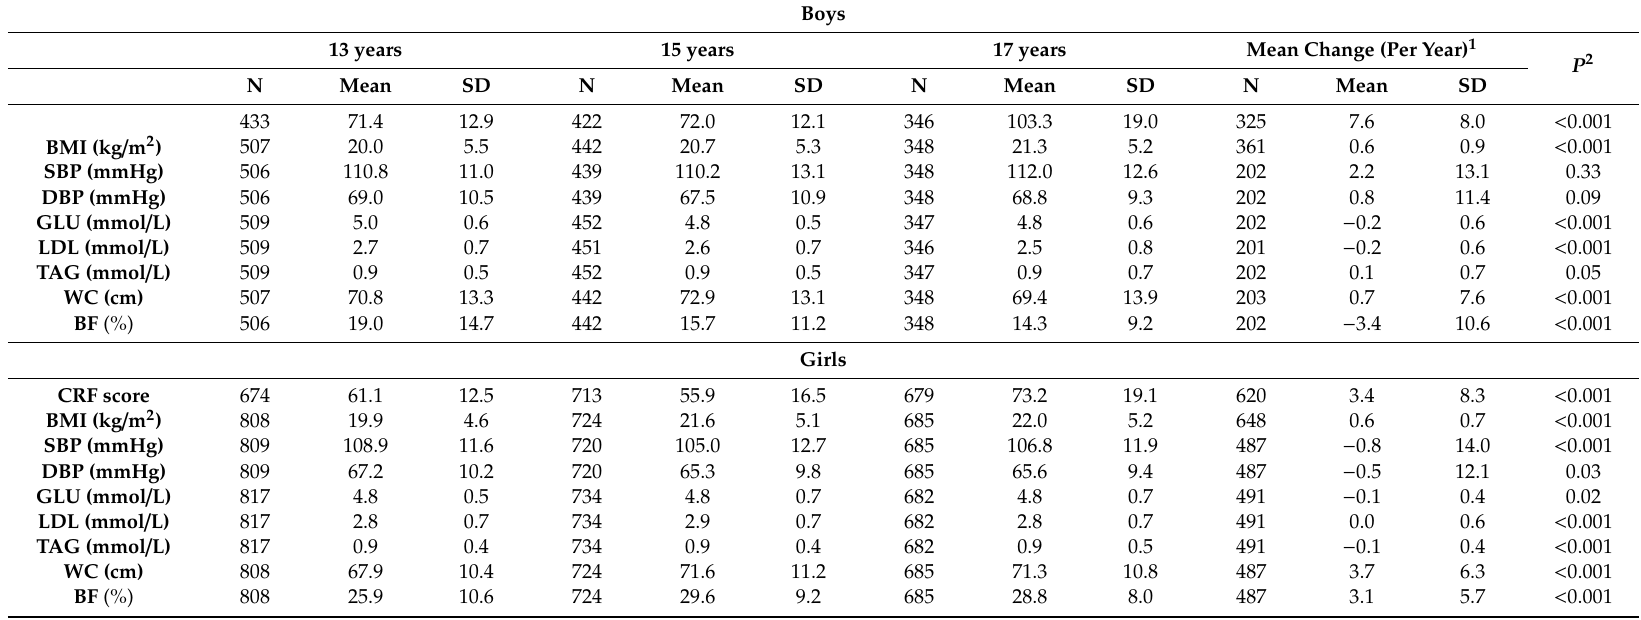
Table 2. Descriptive statistics for Cardiorespiratory Fitness (CRF) score, Body Mass Index (BMI) and cardiometabolic health outcomes in boys and